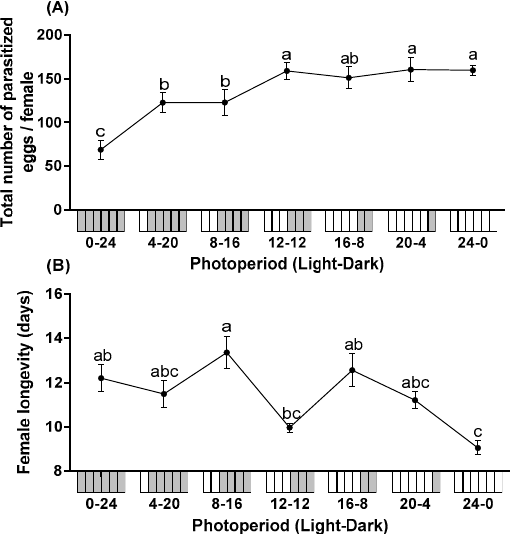
Figure 1. The total number of parasitized eggs per female ( A ) and longevity ( B ) of T. remus using S. litura eggs as alternative host under the different photoperiods. Data are represented as mean ± SE. Different lowercase letters indicate significant differences among several photoperiods at α = 0.05 (Tukey test).